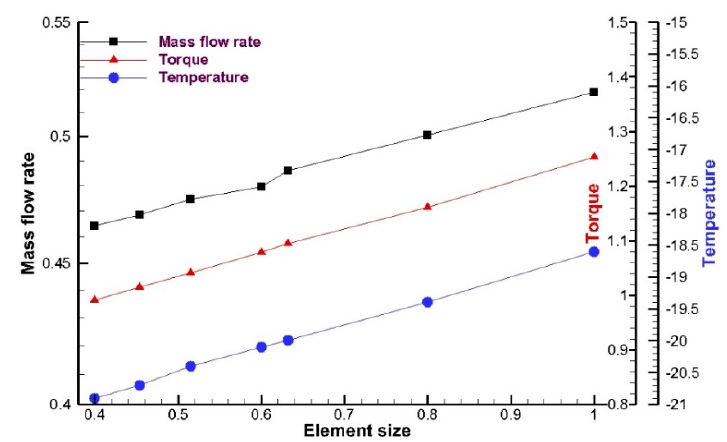
Figure 3. Measurement of dependent variables in the grid dependency test.